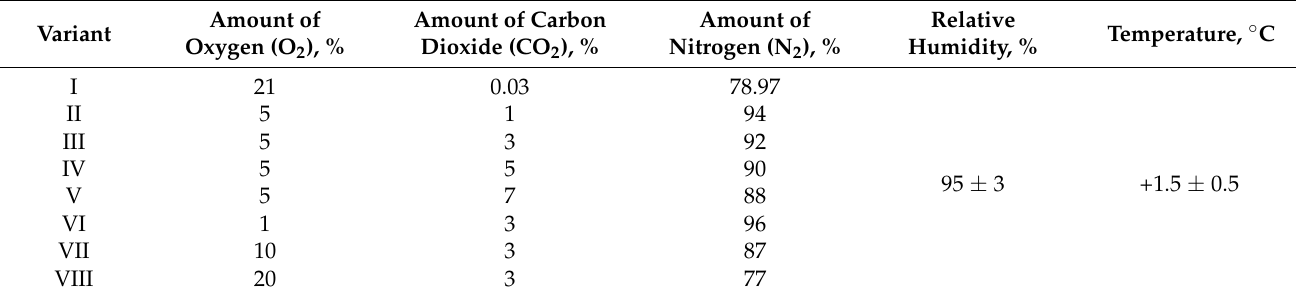
Table 1. Composition of controlled atmosphere